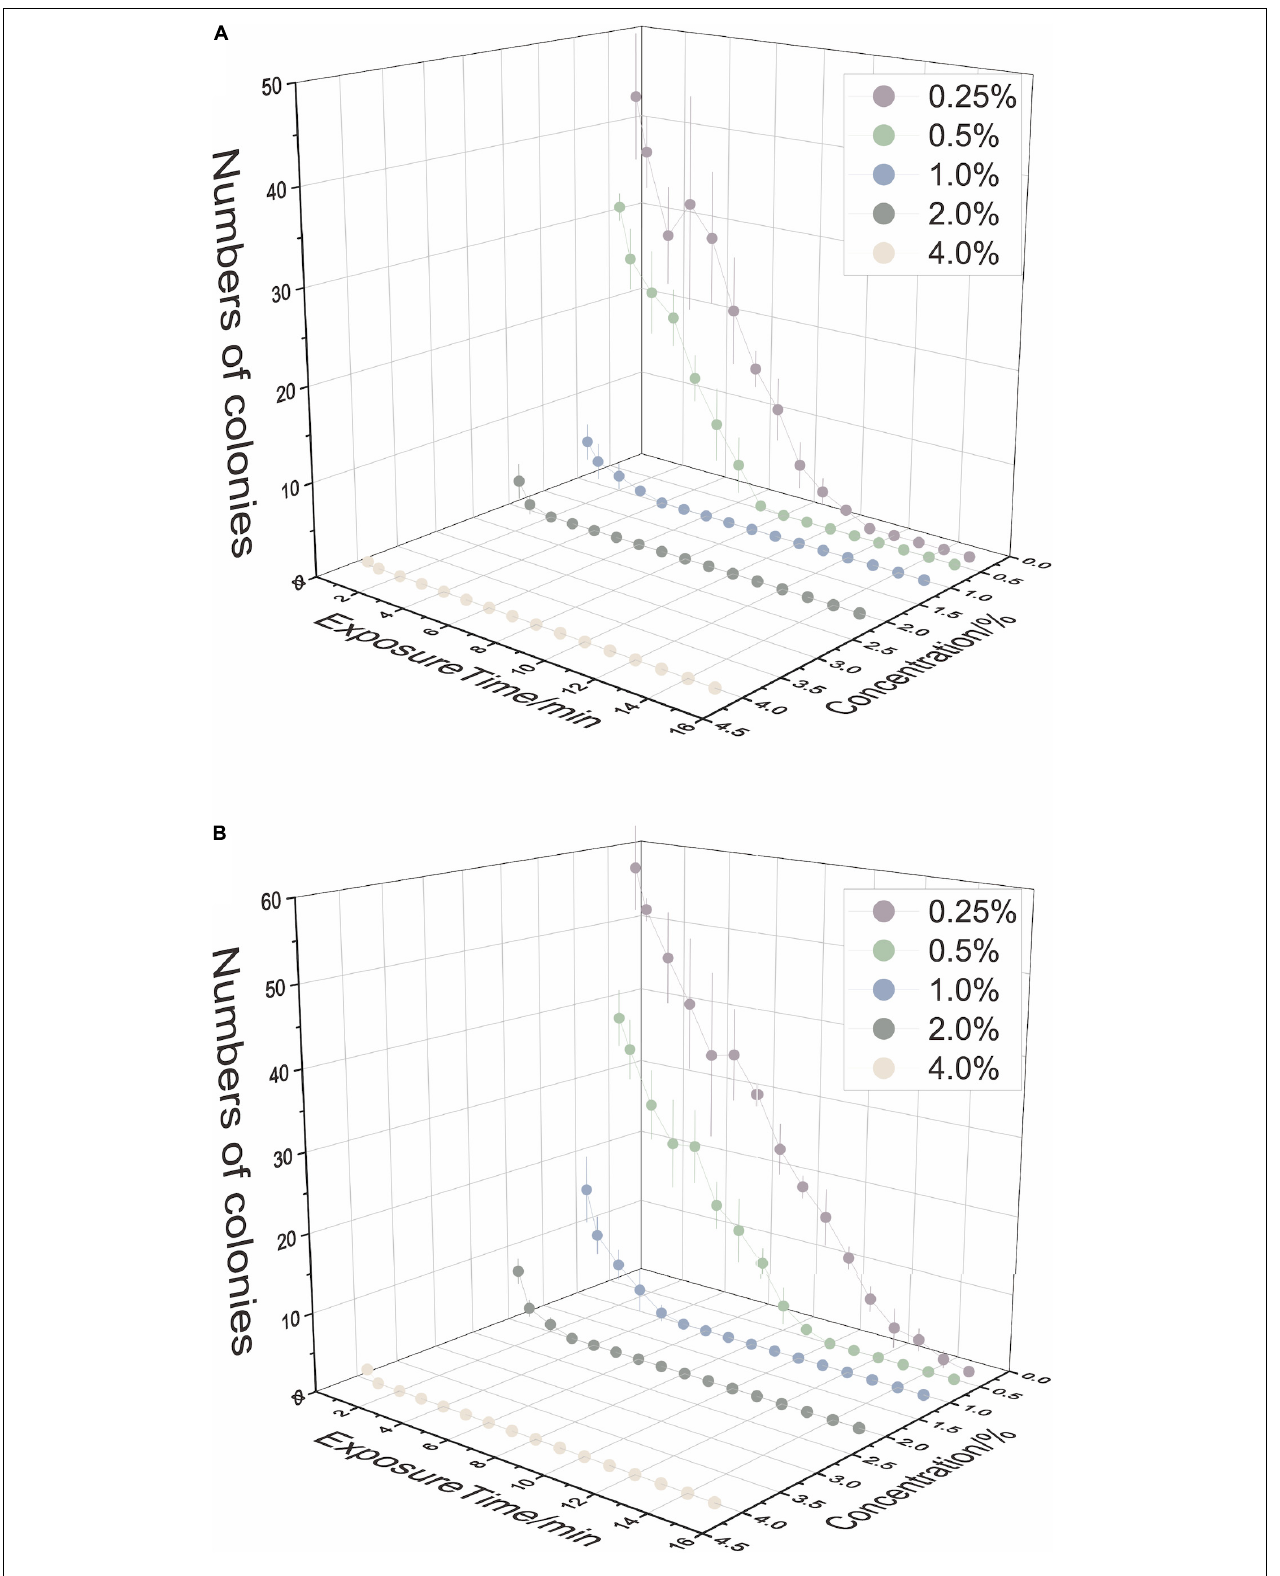
FIGURE 1 | The disinfection ability of sodium hypochlorite (NaClO) concentrations and exposure time on tea plant leaves (A) and stems (B) .